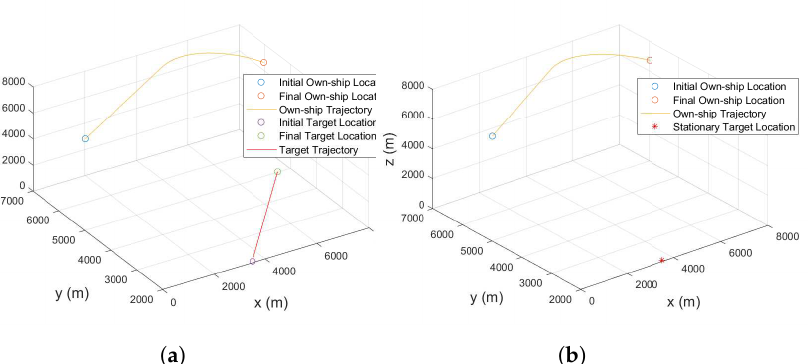
Figure 4. Geometry of the airborne sensor and the ground target with terrain uncertainty. ( a ) Target moves in nearly constant velocity. ( b ) Target remains